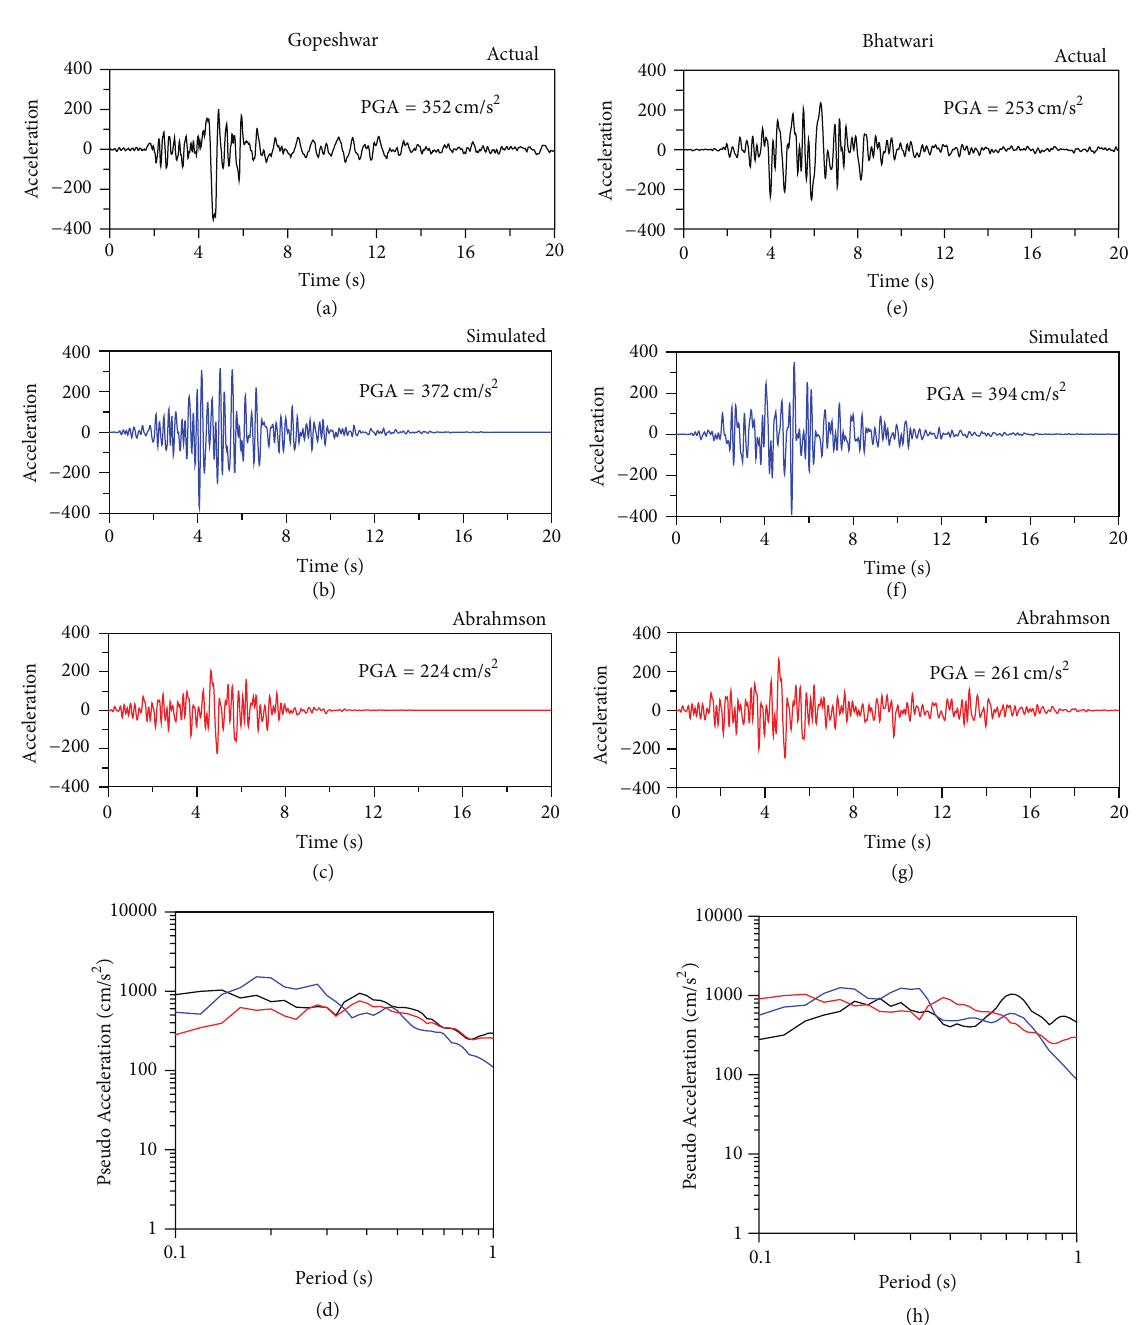
Figure 6: (a) Actual acceleration record, (b) simulated acceleration record using developed attenuation relation for Garhwal Himalaya, (c) simulated acceleration record using the attenuation relation given by Abrahmson and Litehiser [20], and (d) comparison of response spectra at 5% damping from actual and simulated records at Gopeshwar station. (e) Actual acceleration record, (f) simulated acceleration record using developed attenuation relation, (g) simulated acceleration record using the attenuation relation given by Abrahmson and Litehiser [20], and (h) comparison of response spectra at 5% damping from actual and simulated records at Bhatwari station. The black, blue and red lines represent the actual record, simulated record using developed attenuation relation, and that using the attenuation relation given by Abrahamson and Litehiser [20],